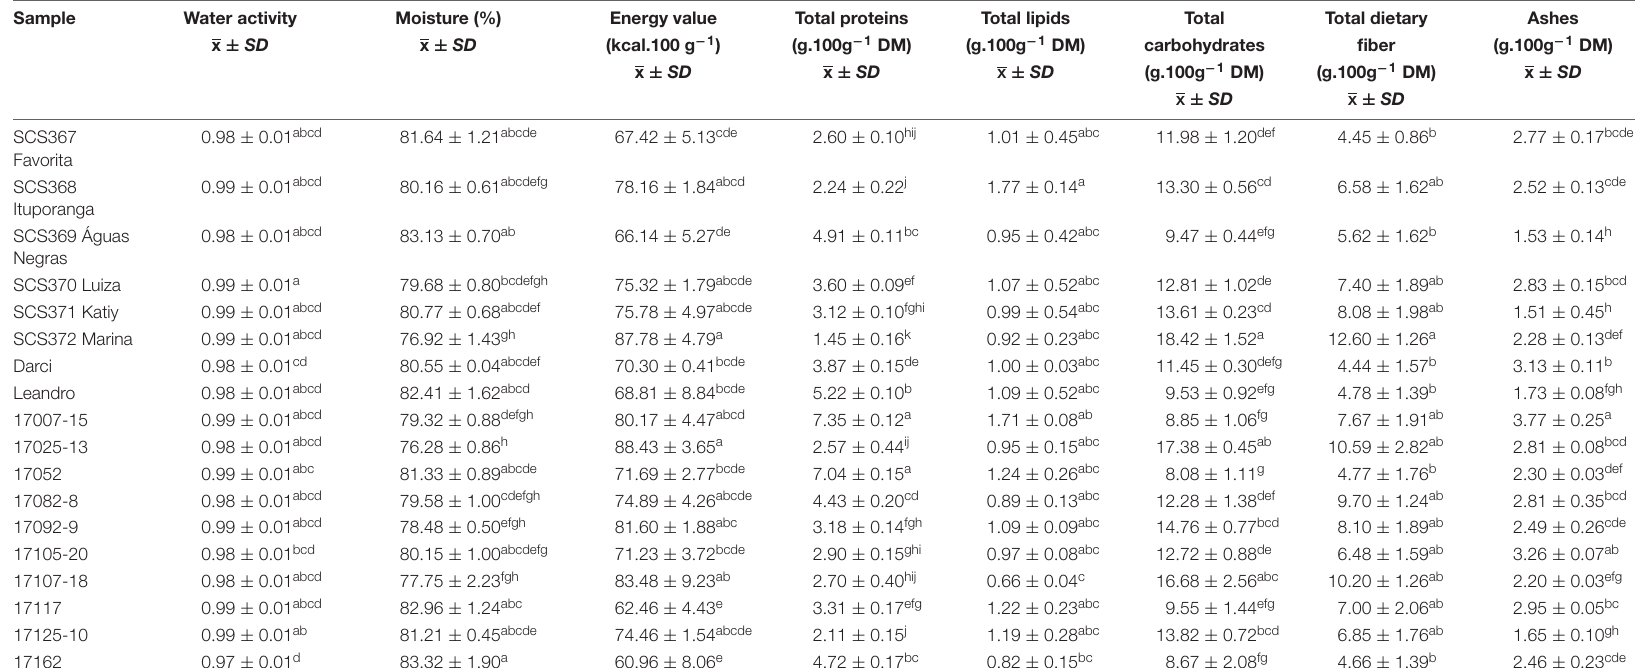
Different letters in the same column show significant differences between samples with 95% certainty by ANOVA and Tukey tests. DM, dry matter. x ± SD, mean and standard